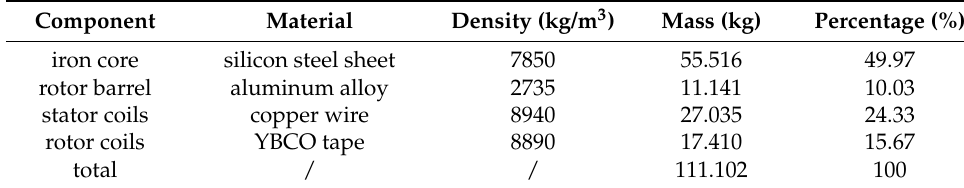
Table 3. Weight of the generator components.